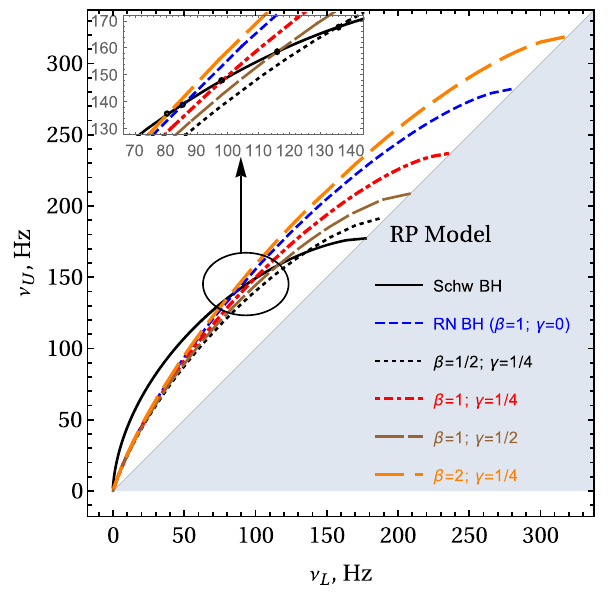
Fig. 12 Possible values of the frequencies of upper and lower peaks of QPOs from charged BHs in EMS gravity in the RP model